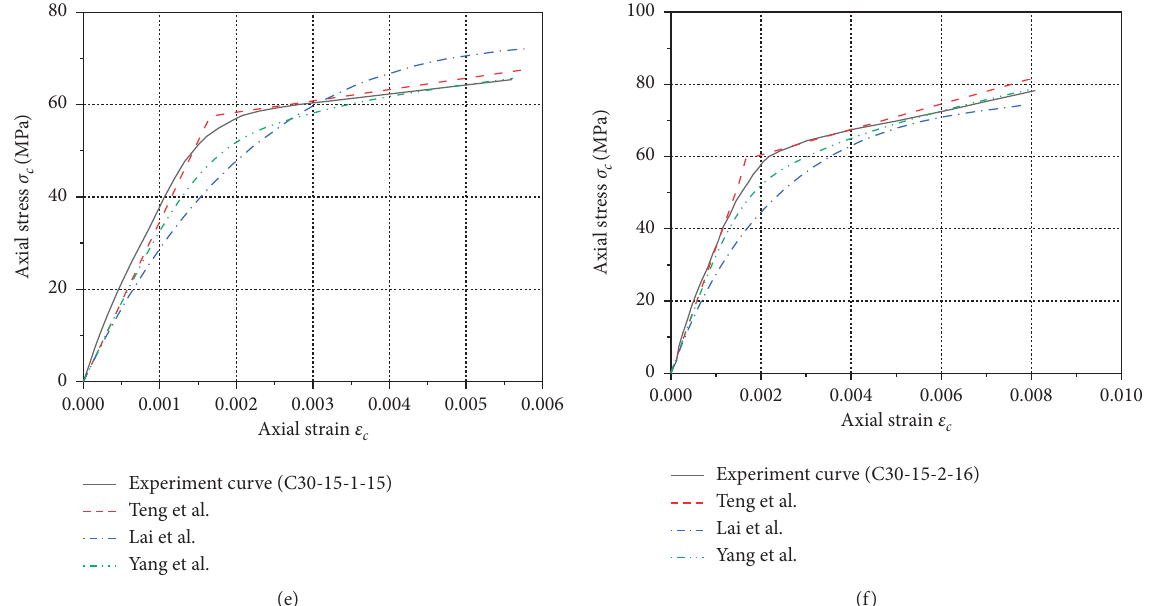
Figure 12: Comparison of calculated stress-strain curves with the experiment curve of group C30. (a) C30-5-1-11. (b) C30-5-2-12. (c) C30-10-1-13.